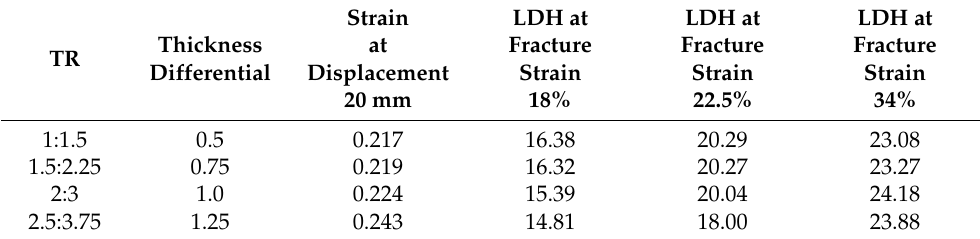
Table 3. Simulation results when thickness ratio fixed as 1:1.5. TR: Thickness Ratios. LDH: Limiting Table 4. Simulation results when thickness ratio fixed as 1:2.